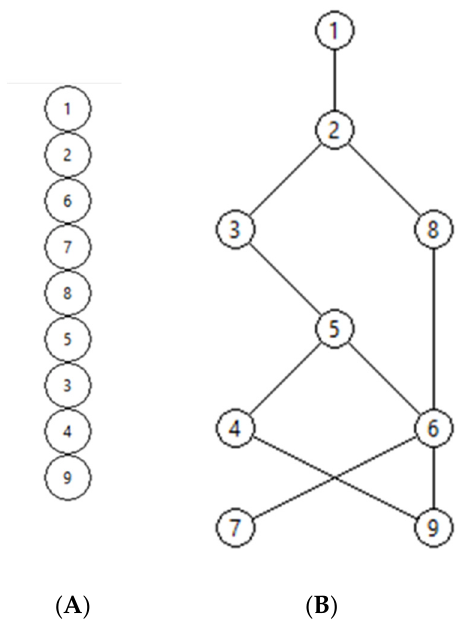
Figure 3. Hasse diagram of the nine nerve agents applying weight regimes ( A ) and data noise ( B ). Note: 9 is covered by 4 and 8 but not 6; 6 is covered by 5 and 8.